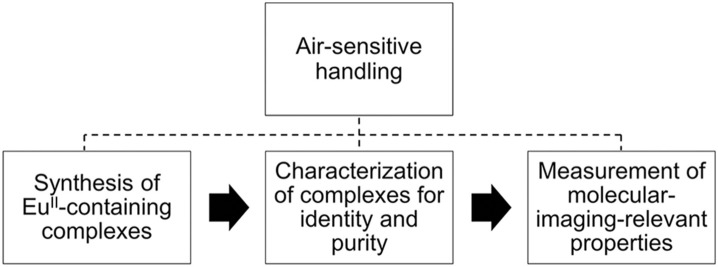
Pathway for EuII-containing complexes that have applications in molecular imaging.